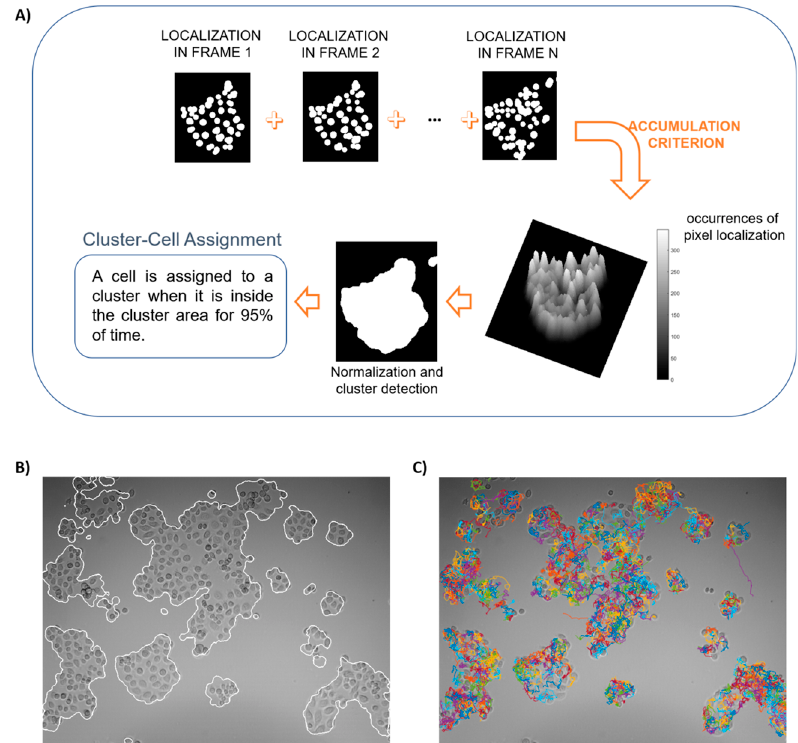
Figure 2. A schematic representation of automatic cell clustering and tracking . A) Automatic cluster- cell assignment procedure. B) Visual result of the automatic cell clustering. C) Cell tracking results cluster-cell assignment procedure. ( B ) Visual result of the automatic cell clustering. ( C ) Cell tracking superimposed on the first video frame. results superimposed on the first video